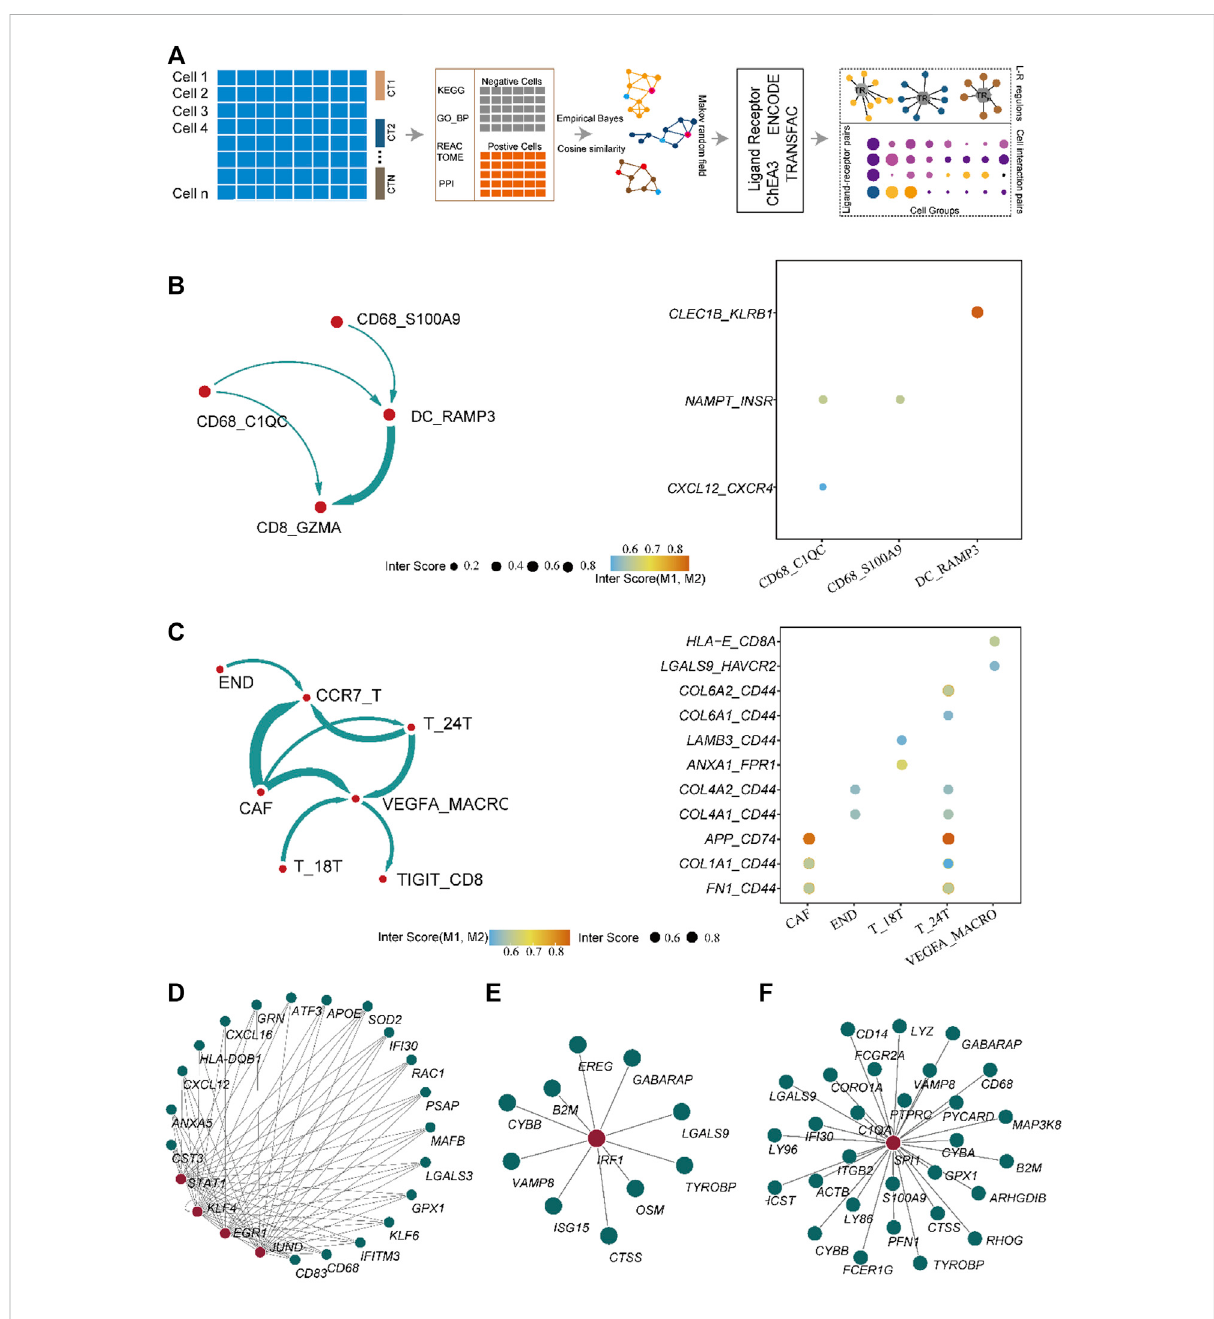
FIGURE 2 Algorithm framework of eLBP and the result calculated by eLBP. (A) Work fl ow of eLBP. Cell communication pro fi le in the normal (B) (left) and cancer tissue (C) , in which line width was positive correlation with thecell interaction strength. Dot plot showing theinteraction genes in thenormal (B) and cancer tissue (C) , in which the row showing the interaction genes and the column showing the interaction cell types. The network showing thecritical transcriptionfactor (TF) regulons in normal (D) and cancer tissue (E,F) , inwhichred nodes were TFs and theother nodes were target